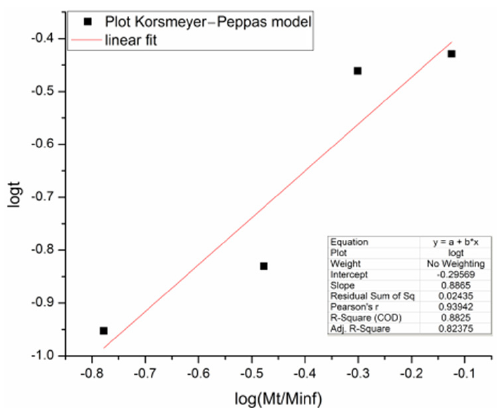
Figure 9. Release profiles of the IBU from the hydrogel impregnated with a 0.5 g mL − 1 IBU solution; ( (cid:4) ) at pH 2 and ( (cid:3) ) at pH 7: ( a ) 0–1440 min and ( b ) 0–120 min.